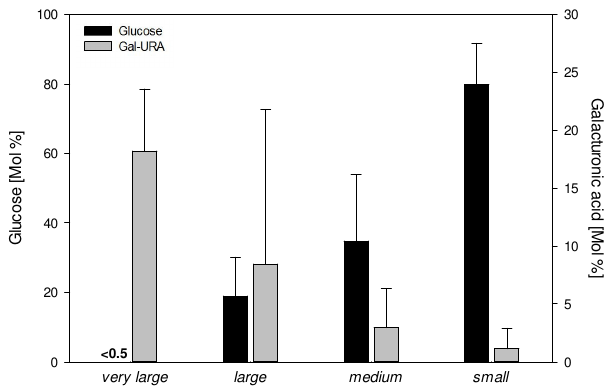
Figure 4. Proportions of glucose (Glc) and galacturonic acid (Gal- URA) in high-molecular-weight (HMW > 1kDa) dissolved com- bined carbohydrates ( d CCHO) of different molecular weight size classes as defined in Table 1. Due to the strong similarity between the present-day and high-CO 2 culture, both were treated as repli- cates. Bars show the average ( ± standard deviation) of replicate samplings (sampling 3–5, n = 6) performed during the steady-state period of the